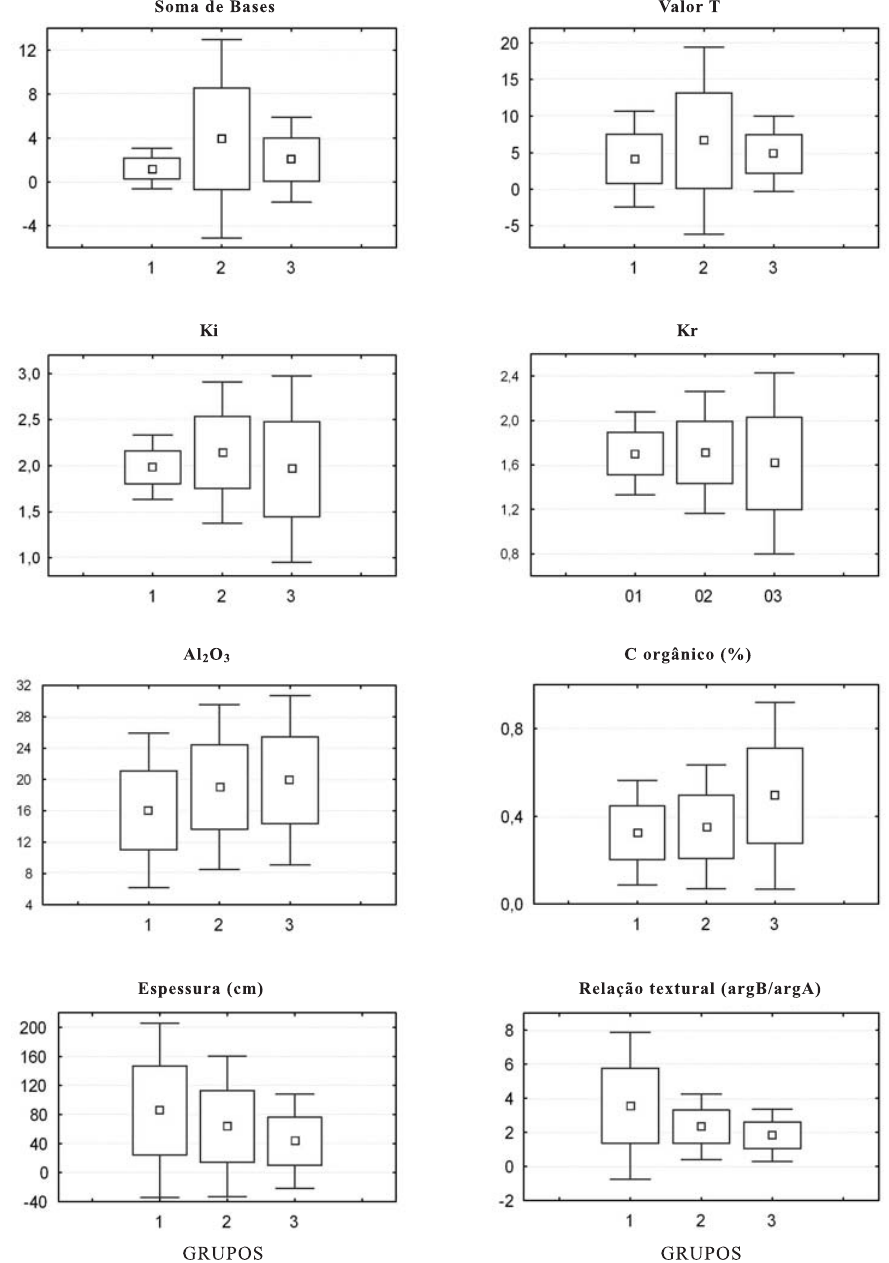
Figura 2. Representação gráfica da média, desvio-padrão e intervalo de confiança (desvio-padrão x 1,96) das variáveis entre os grupos definidos: 1 = TC, 2 = PR, e 3 = PS. Onde: média; ± desvio-padrão e intervalo de